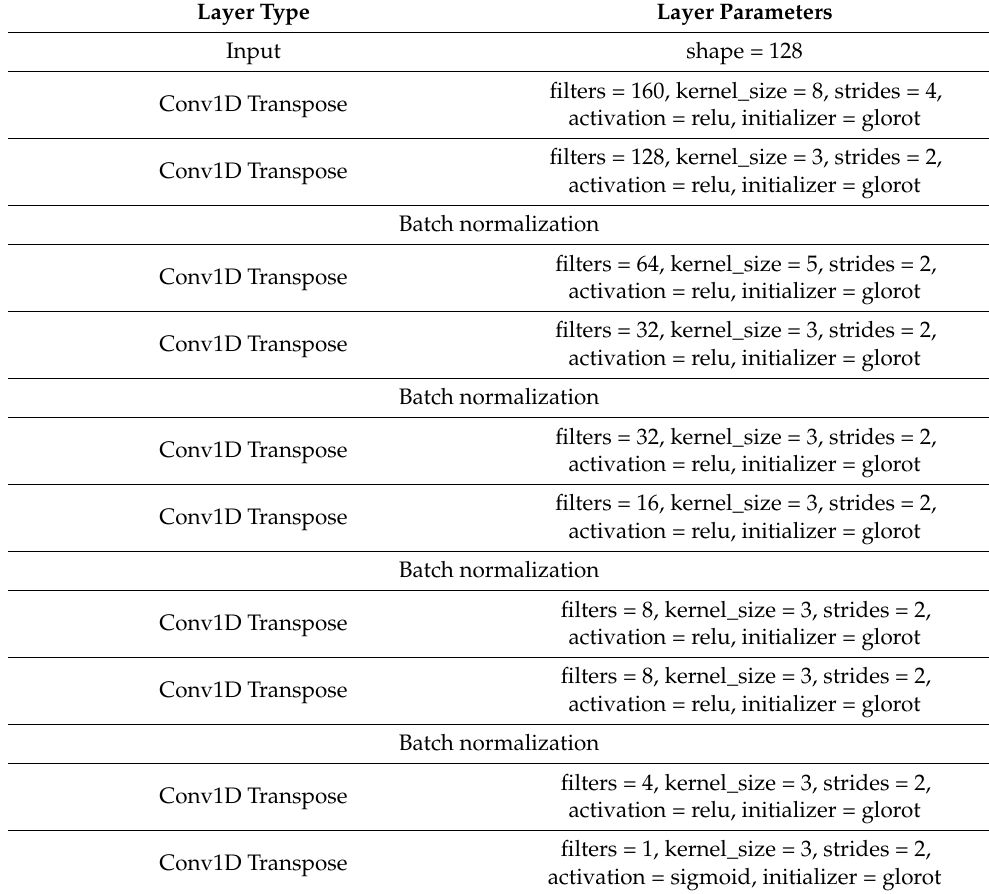
Table 3. Configurations of